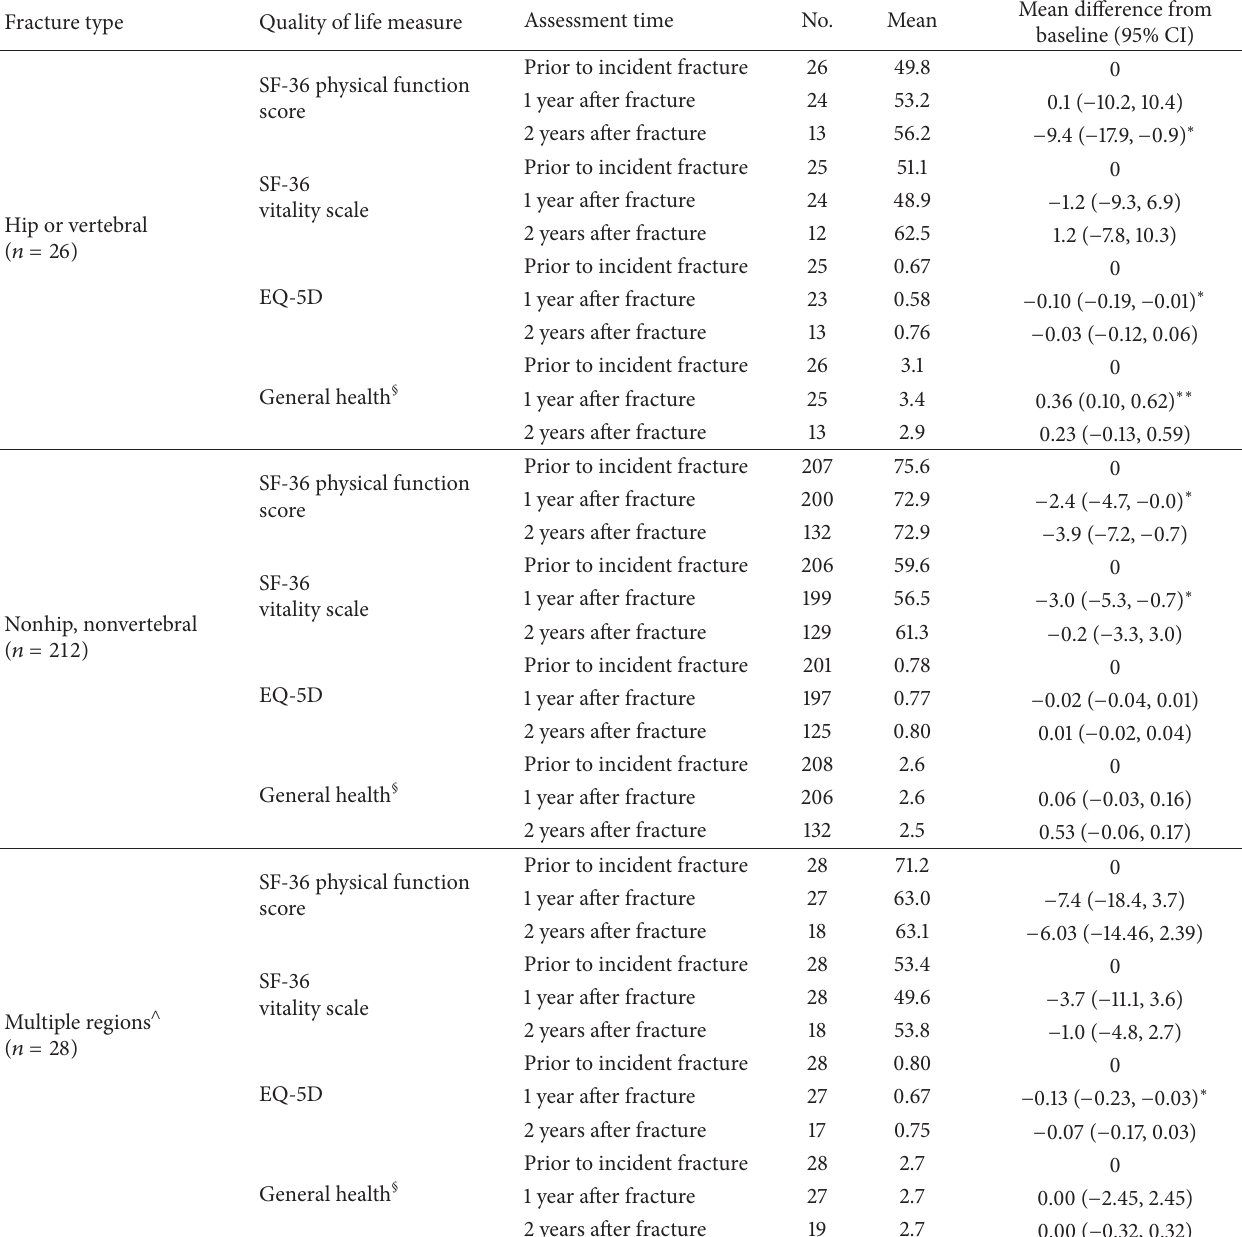
Table 3: Changes in health related quality of life measures according to fracture